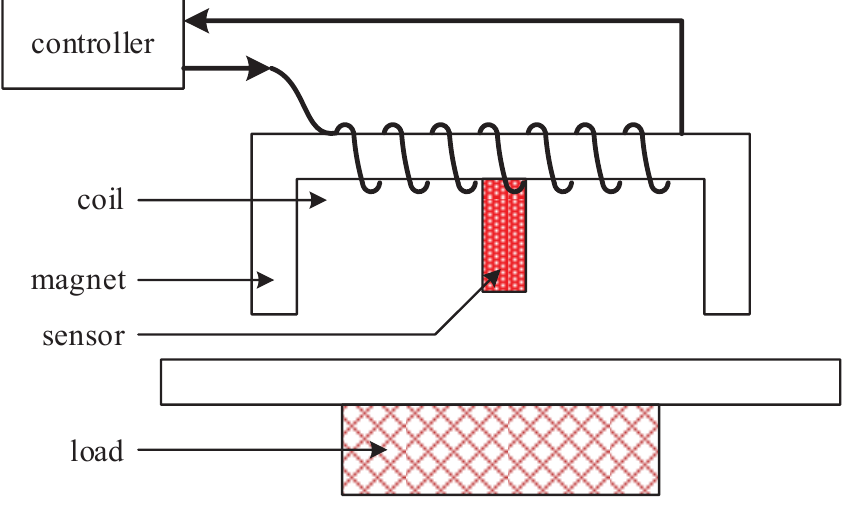
Figure 1. The suspension control system of the electromagnetic thrust